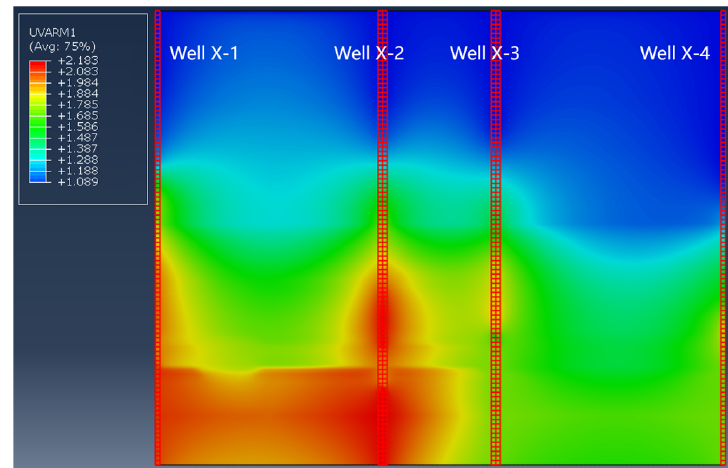
Figure 8. Values of the pressure coefficient at any position in profile A.